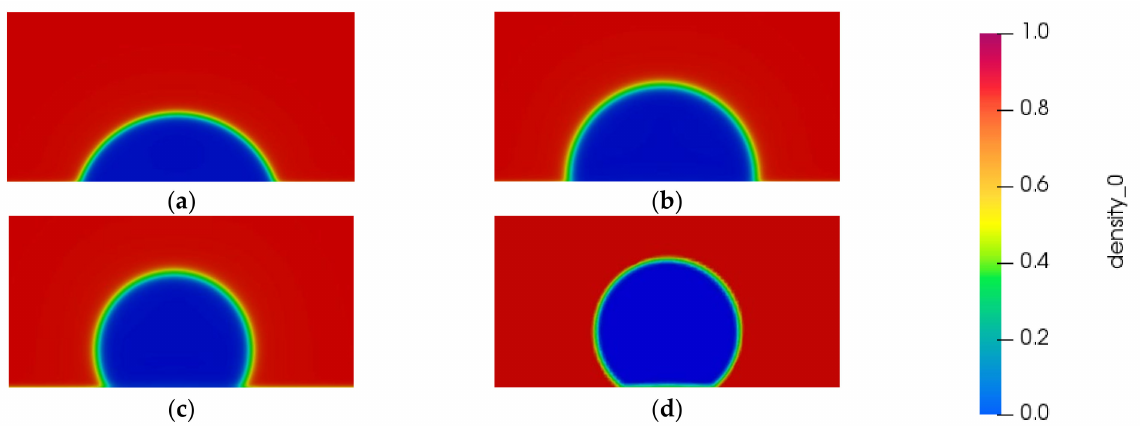
Figure 3. Water droplet contour for different contact angles obtained through adjusting the interaction parameter g ( a ) θ eq = 70. ( b ) θ eq = 90 ◦ . ( c ) θ eq = 120 ◦ . ( d ) θ eq = 130 ◦ .